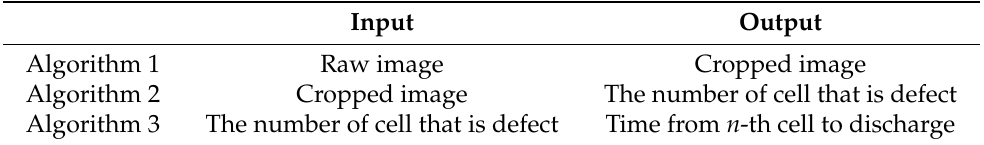
Table 1. Algorithms performed in Edge Box.